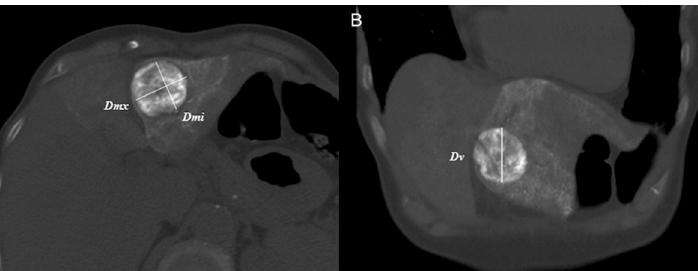
Fig 3. Measurement of three-dimensional (3-D) tumor diameters. Axial (a) and coronal (b) CT images best depicting index tumor serving in 3-D diameter measurements as follows: maximum diameter (Dmx) and perpendicular minimum diameter (Dmi) in axial image (a), and vertical diameter (Dv) in coronal image (b). Note: a preset bone window setting (width, 3000 HU; level, 500 HU) is applied to avoid beam-hardening artifact due to iodized oil retention by index tumors or surrounding